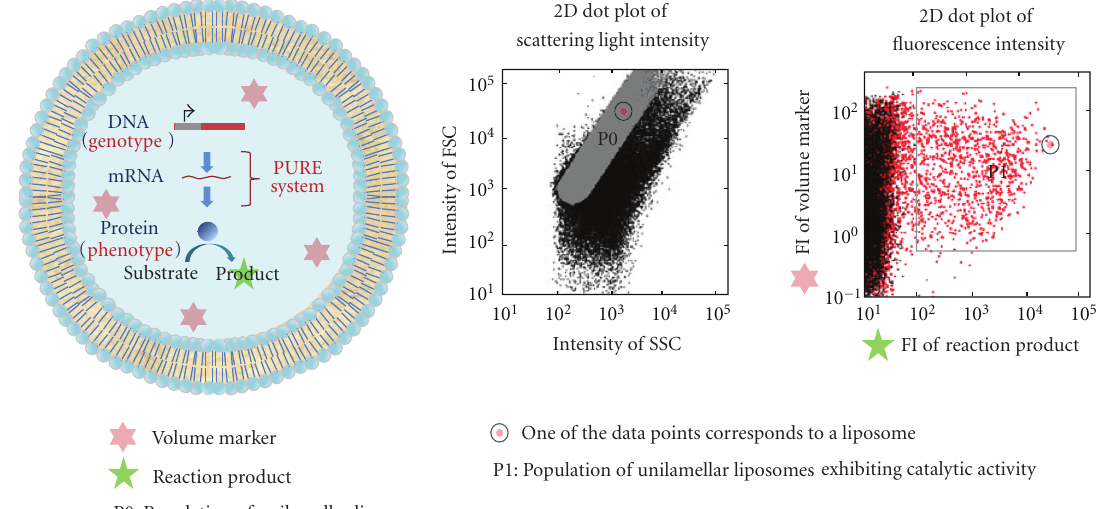
Figure 5: Characterization of in-liposome protein synthesis using an FACS. DNA, PURE system, fluorogenic substrate, and fluorescent volume marker are encapsulated in a giant unilamellar liposome (left). Subpopulation of unilamellar liposomes is represented by P0 in 2D dot plot of scattering light intensity (middle). Catalytic activity of enzymes expressed in liposomes is confirmed in P1 region of 2D dot plot of fluorescence intensity obtained by FACS measurement